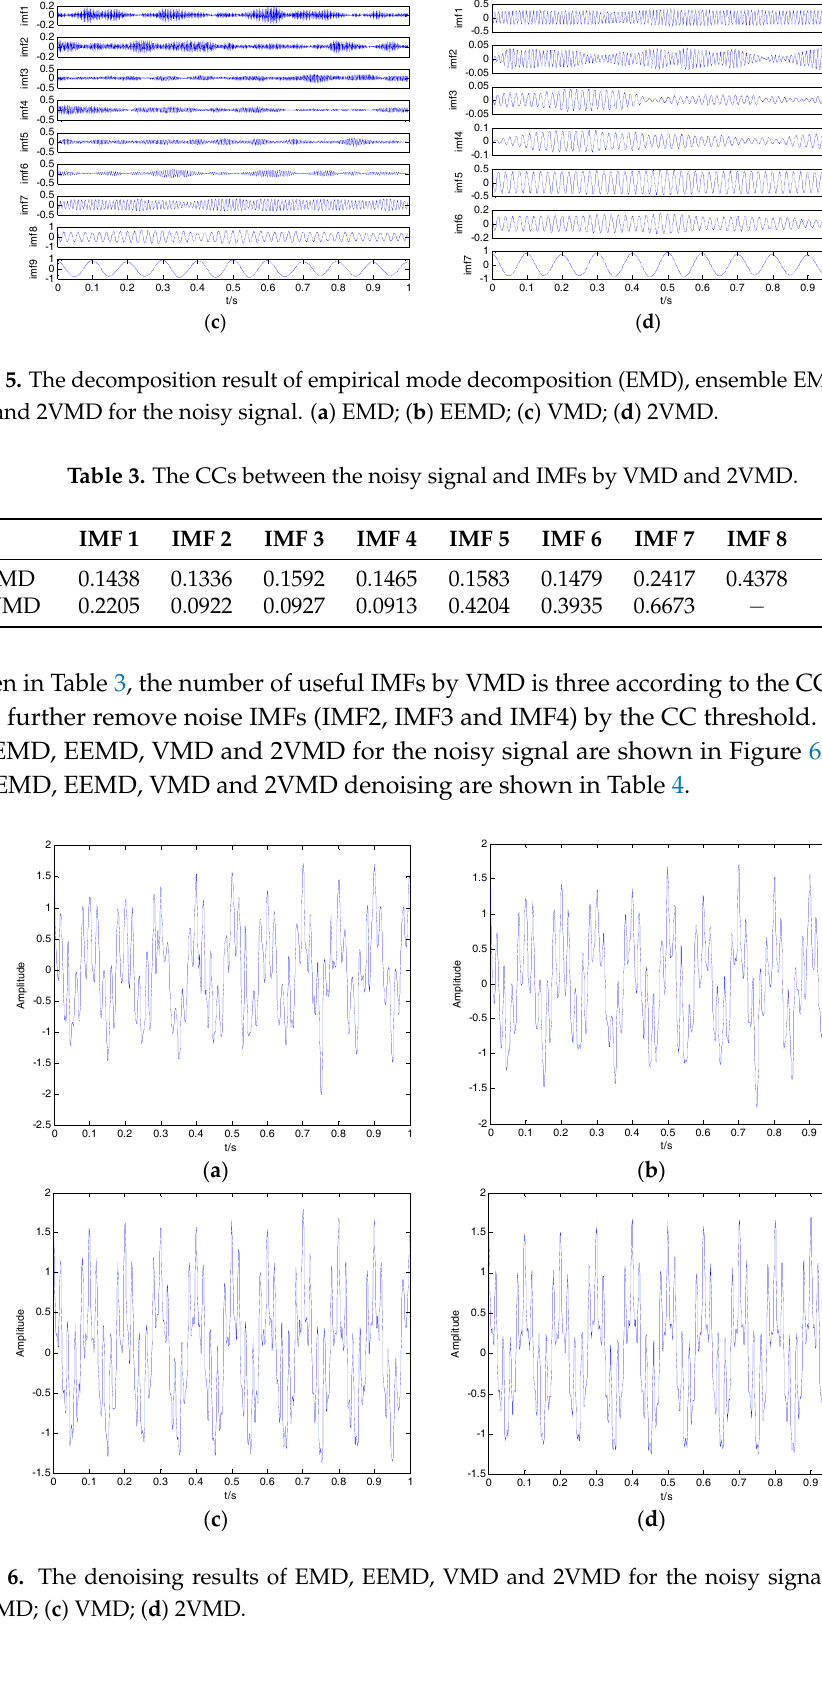
Figure 6. The denoising results of EMD, EEMD, VMD and 2VMD for the noisy signal. ( a ) EMD; ( b ) EEMD; ( c ) VMD; ( d ) 2VMD.